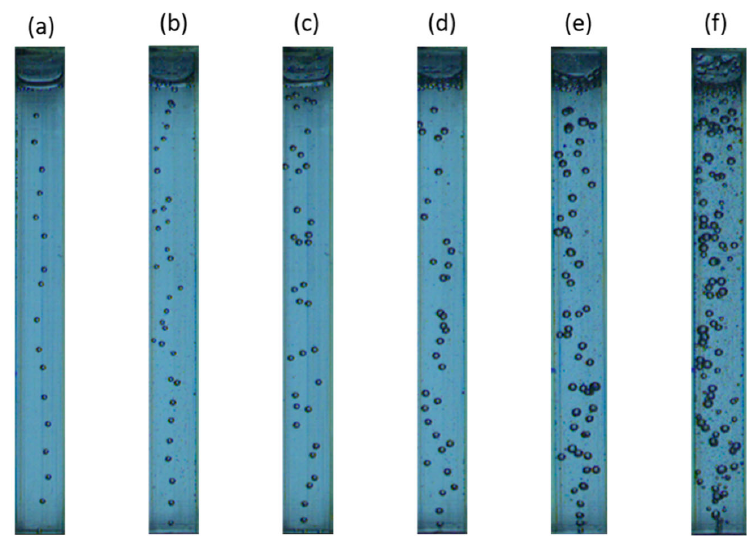
Figure 4. Representative pictures of bubble flow regimes with the increase of gas flowrate under a static liquid flow. d G = 100 μ m. ( a ) Q G = 3.7 mL/min; ( b ) Q G = 5.4 mL/min; ( c ) Q G = 9.9 mL/min; ( d ) Q G = 15.5 mL/min; ( e ) Q G = 22.9 mL/min; ( f ) Q G = 32.7 mL/min.